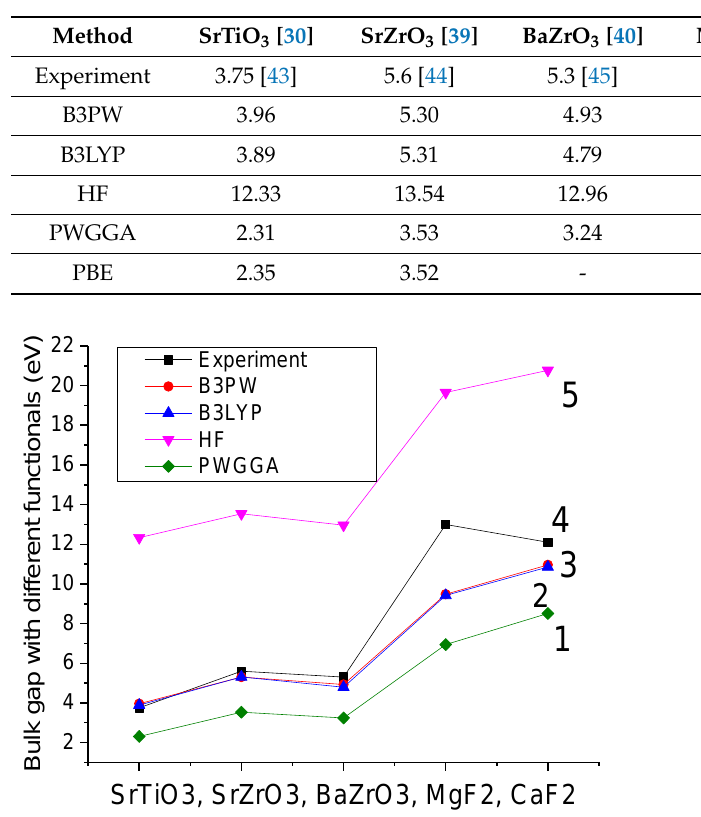
Table 1. By means of different exchange–correlation functionals calculated SrTiO 3 , SrZrO 3 , BaZrO 3 , MgF 2 and CaF 2 bulk Γ–Γ band gaps (eV). Experimental bulk band gaps at the Γ-point are listed for comparison.